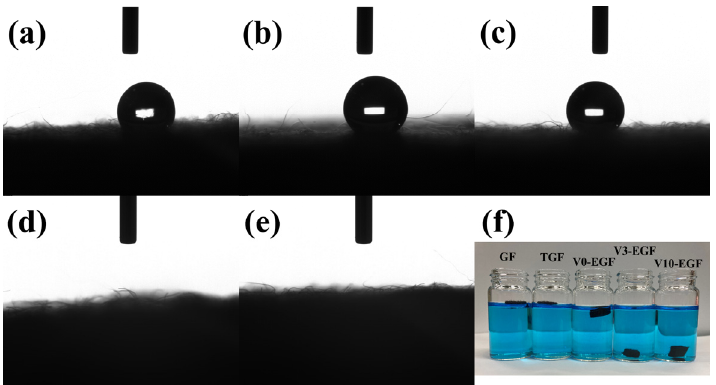
Figure 3. The contact angle of the graphite felt : ( a ) GF, ( b ) TGF, ( c ) V0-EGF, ( d ) V3-EGF, ( e ) V10- EGF, and ( f ) digital photos of electrolyte accessibility test of GFs. and ( f ) digital photos of electrolyte accessibility test of